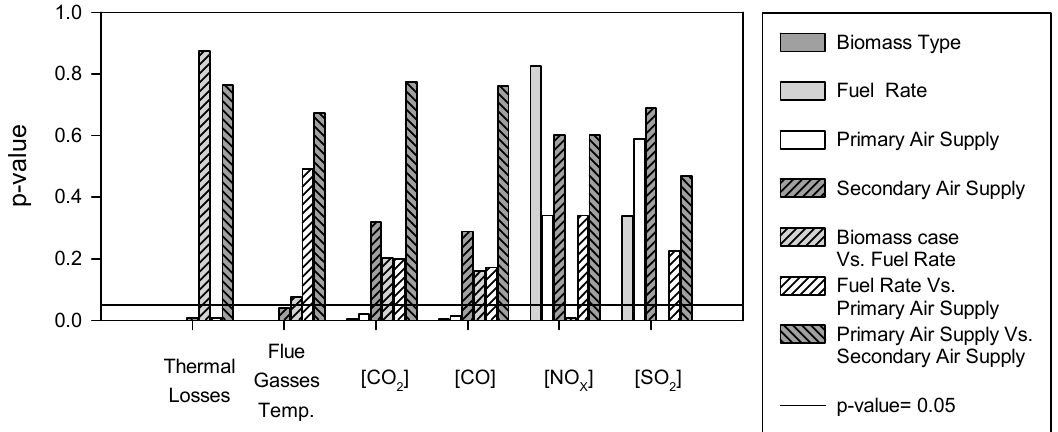
Figure 10. p -value estimated from the analysis of variance performed to study the influence of the four factors (and their combined interactions) on various variables; confidence level—95%.